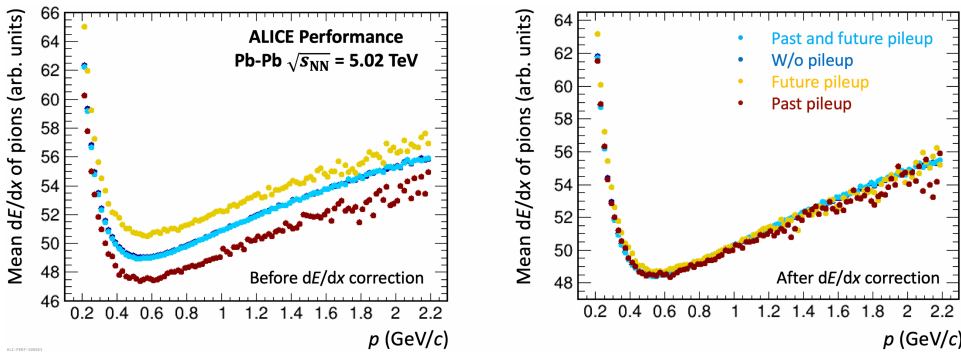
Figure 7. (Color online) Mean d E /d x values of pions for the events with and without out-of-bunch pileup before ( left ) and after ( right ) d E /d x correction.